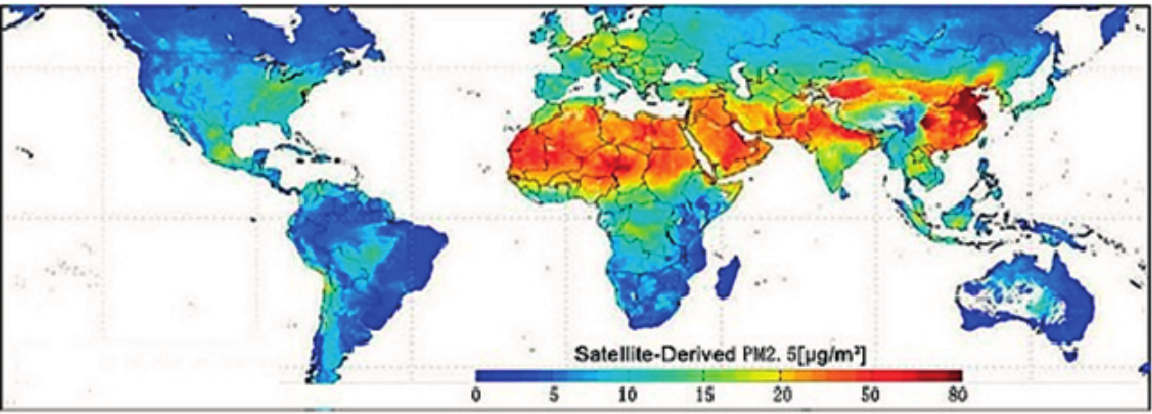
Figure 1. The global distribution of PM 2.5 averaged over 2001–2006 (Credit: Dalhousie University, Aaron van Donkelaar, http://www.nasa.gov/topics/earth/features/healthappoing.